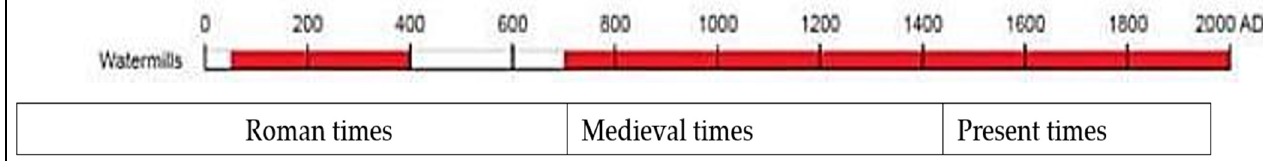
Figure 14. Development of water mills in the UK (adapted from [35]).